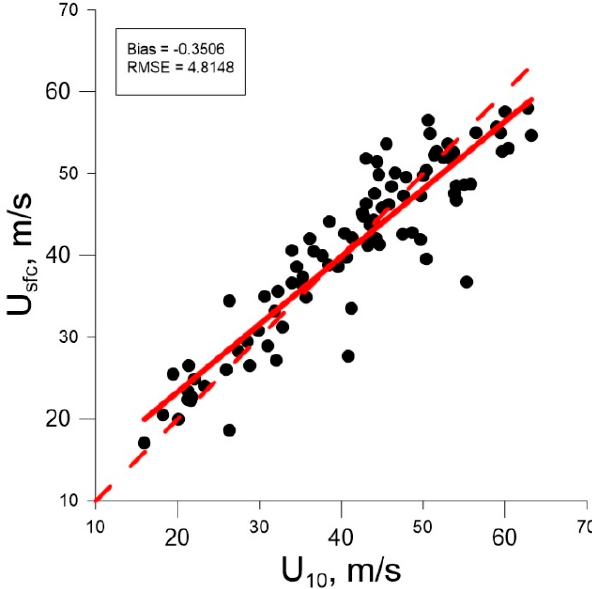
U calculated U , determined in [19] and 10 sfc U + 6.79. Bias = U = 0.83 10 sfc